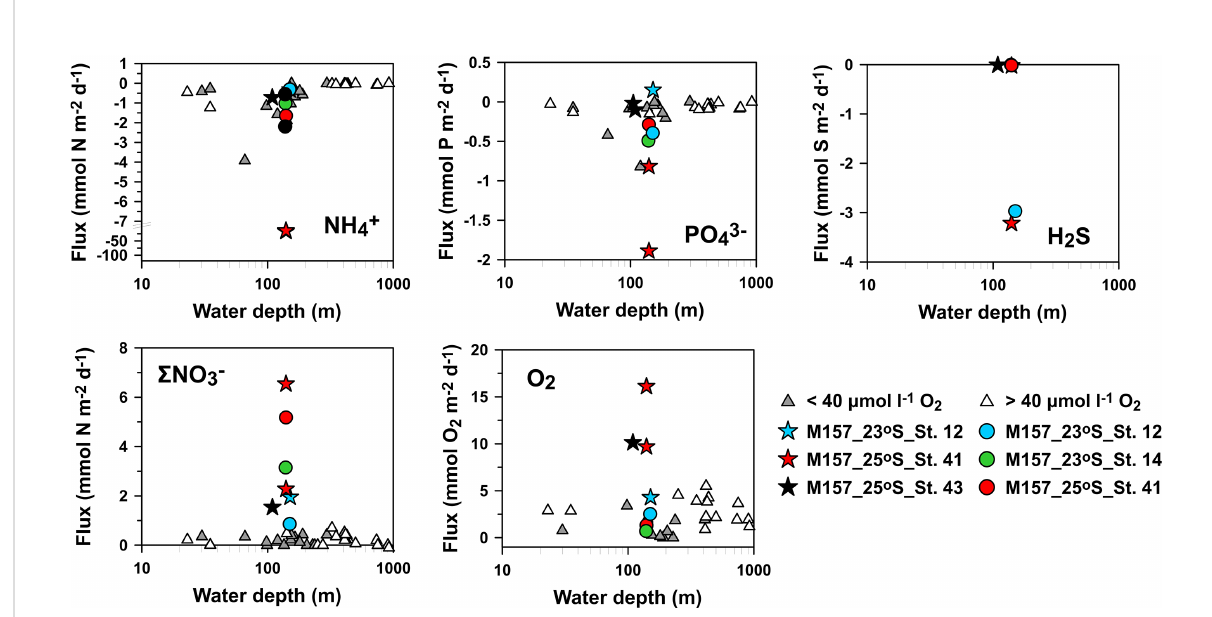
FIGURE 6 Comparison of modeled benthic fl uxes (circles) with in situ benthic fl uxes measured using benthic chambers during M157 (stars; Sommer et al., in prep.) and ex situ diffusive fl uxes (triangles; Neumann et al., 2016) versus water depth (logarithmic scale). Ranges of modeled benthic fl uxes for St. 14 (green bars) and St. 41 (red bars) re fl ect a sensitivity analysis with and without sul fi de oxidation by large sulfur bacteria (LSB). Note the axis break for NH + 4 . Positive fl uxes are directed into the sediment and vice versa. Note that red and green circles overlap in the H 2 S